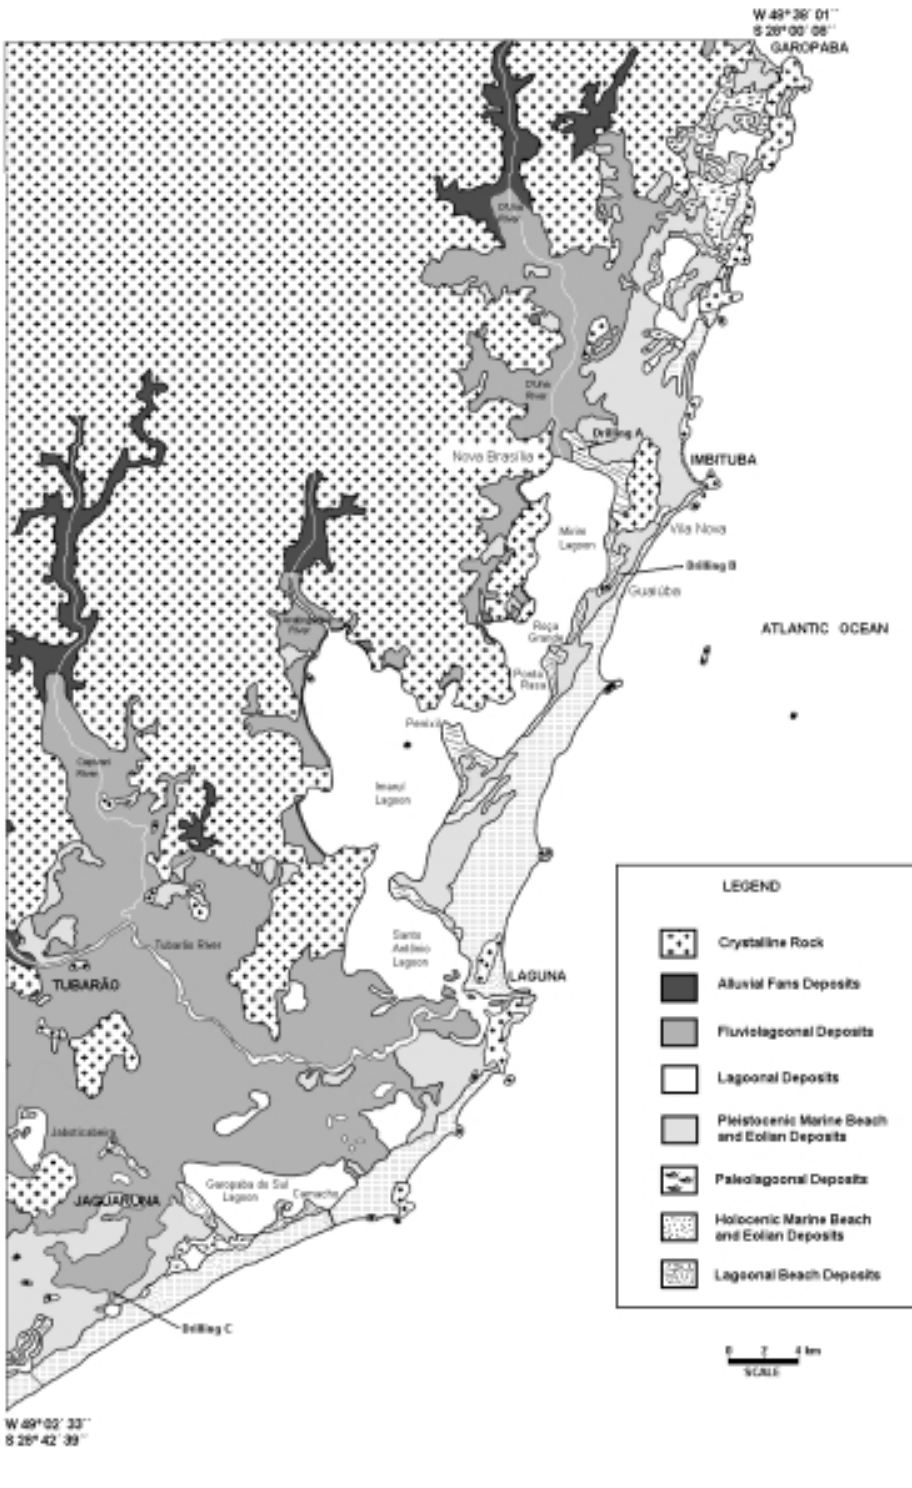
Fig. 1 – Geological map (simplified) of the studied area.